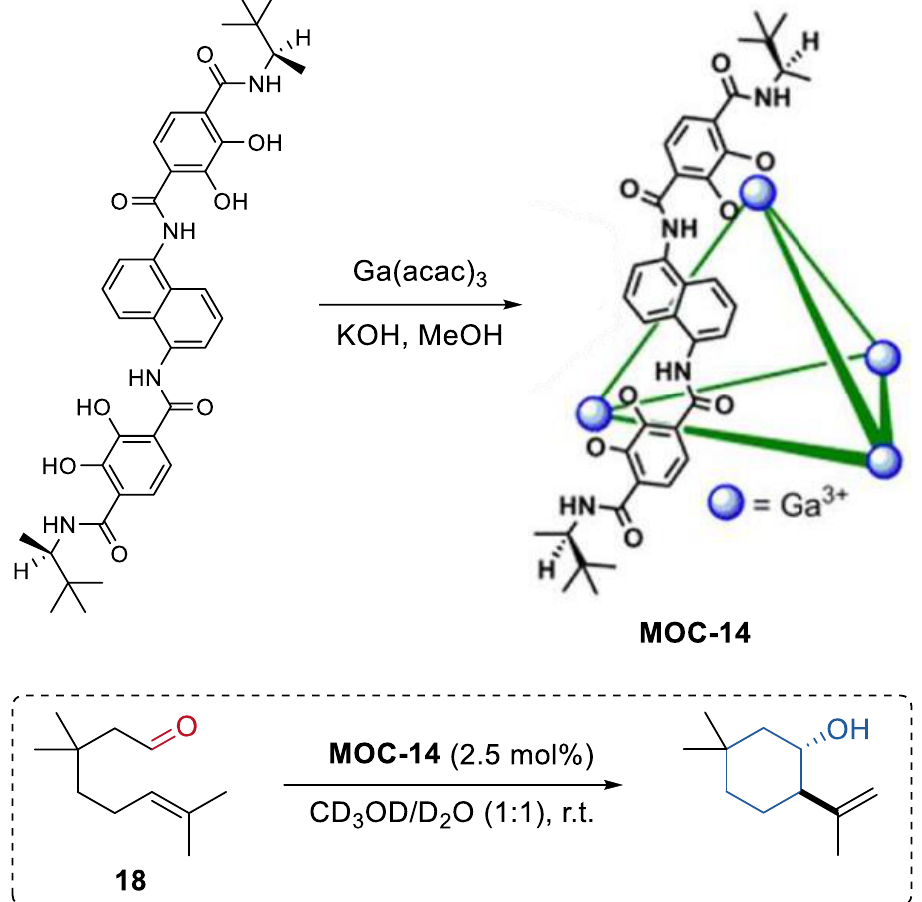
Figure 14. Prins cyclizations of monoterpene catalyzed by MOC-14 [81]. Reaction additions: 18 (0.04 mmol), MOC-14 (2.5 mol%), CD 3 OD/D 2 O (0.5 mL), pD = 8, r.t. Reprinted/adapted with permission from Ref. [81]. Copyright 2013 American Chemical Society.